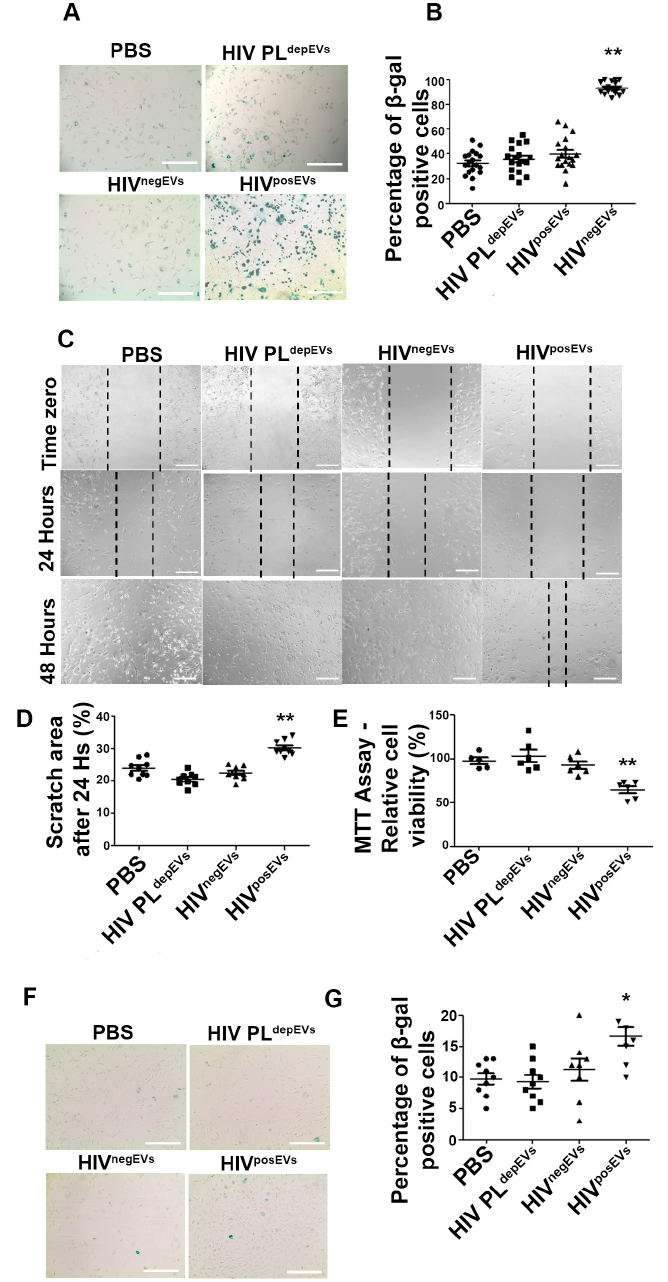
Figure 4. HIV posEVs promote lin − BMC senescence and impair lin − BMC functions in vivo and in vitro. ( A , B ). Lin − BMCs isolated from HIV posEVs -treated apoE − / − mice show increased β -gal staining, as compared with lin − BMCs from mice treated with HIV PL depEVs , HIV negEVs or PBS. ( C , D ). Lin − BMCs from HIV posEVs -treated apoE − / − mice show slower migration than cells from mice treated with HIV PL depEVs , HIV negEVs or PBS. Dashed lines in panel C mark the edges of the scrach in the cell monolayer. ( E ). Lin − BMCs from HIV posEVs -treated apoE − / − mice display reduced proliferation in comparison with control treatments. ( F , G ). Lin − BMCs isolated from 3-week-old untreated apoE − / − mice were treated in vitro with HIV posEVs for 96 h, which resulted in increased percentage of senescent cells ( β -gal staining) than lin − BMCs treated with HIV PL depEVs , HIV negEVs or PBS. For the in vivo experiment, each group had five animals. For the in vitro experiment, all experiments were performed in triplicate and repeated thrice (* p < 0.05, ** p < 0.001). Statistical tests used: Kruskal–Wallis and Dunn’s Multiple Comparison Test as a post test. Scale bars: ( A , F ): 200 µ m; ( C ): 400 µ